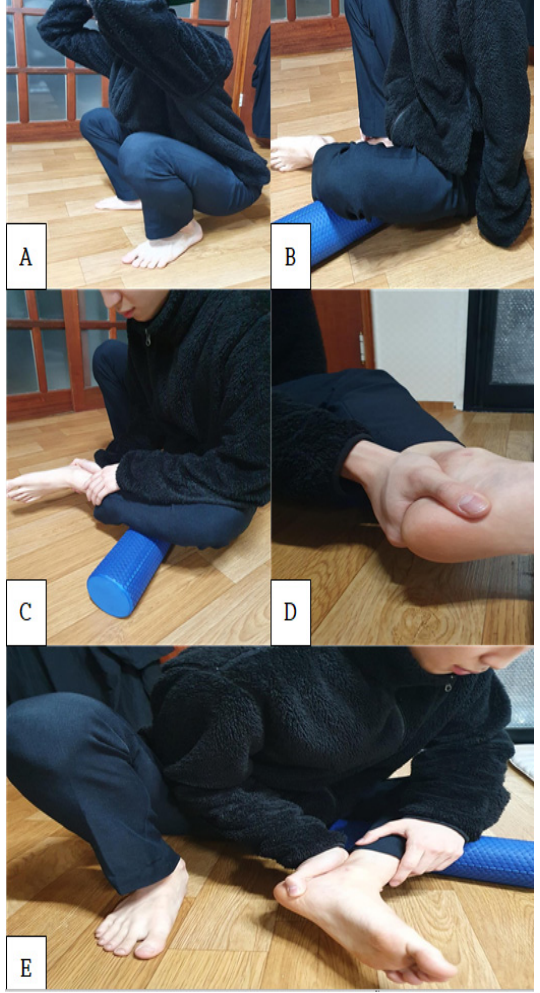
Figure 2. Myofascial release of the peroneus longus muscle. ( A ) squat, ( B ) hip abduction and lateral rotation, the peroneus longus muscle was placed on the foam roller, ( C ) clasp the area above the ankle, ( D ) clasp the lateral talus ( E ) myofascial release of the peroneus longus muscle.